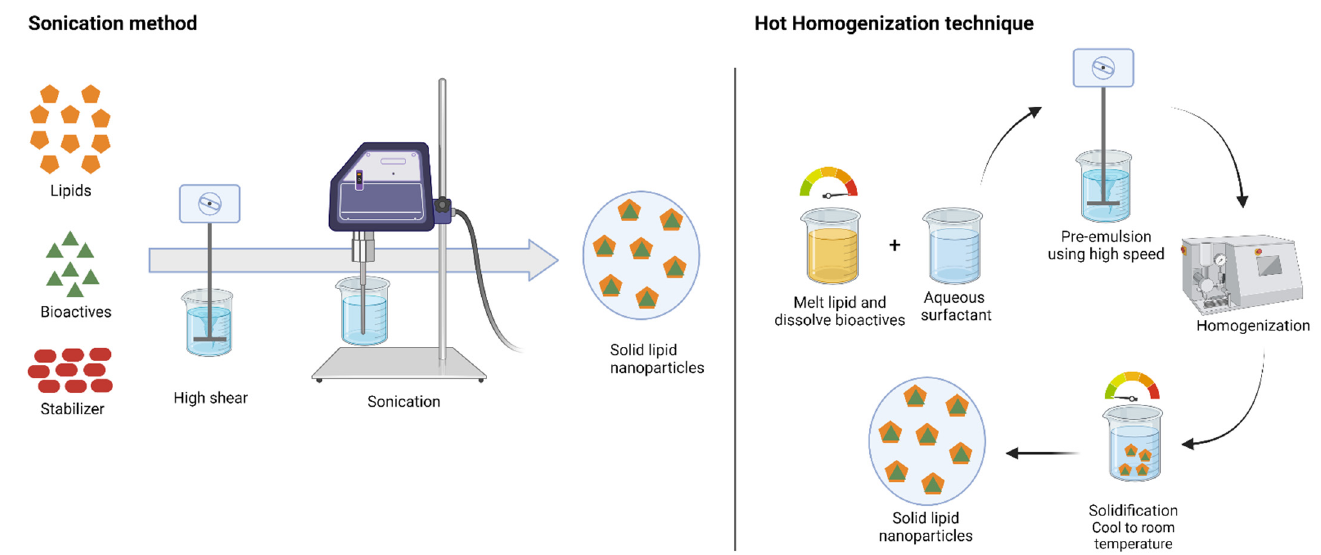
Figure 5. Schematic representation of popular solid lipid nanoparticle production method (created with Biorender.com).